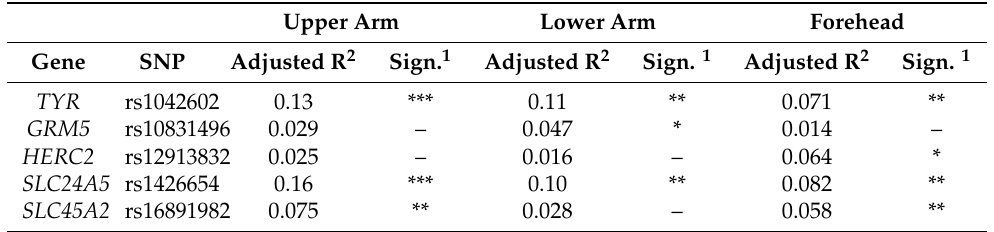
Table 1. Five SNPs with statistically significant association with skin pigmentation on the upper arm, lower arm, or forehead in 299 Pakistani individuals from three subpopulations (Baloch, Pashtun, and Punjabi). Upper Arm Lower Arm Forehead Gene SNP Adjusted R 2 Sign. 1 Adjusted R 2 Sign. 1 Adjusted R 2 Sign. 1 TYR rs1042602 0.13 *** 0.11 ** 0.071 0.064 * SLC24A5 rs1426654 0.16 0.10